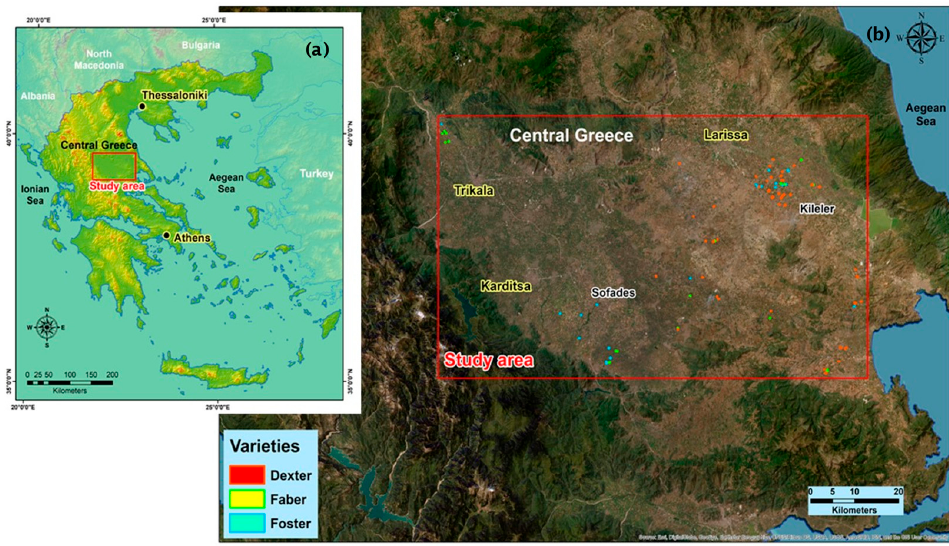
Figure 1. The study area: ( a ) map of Greece and the location of the study area; ( b ) the distribution of fields in the study area. Table 1. Acquisition dates of satellite data for the 2021 growing